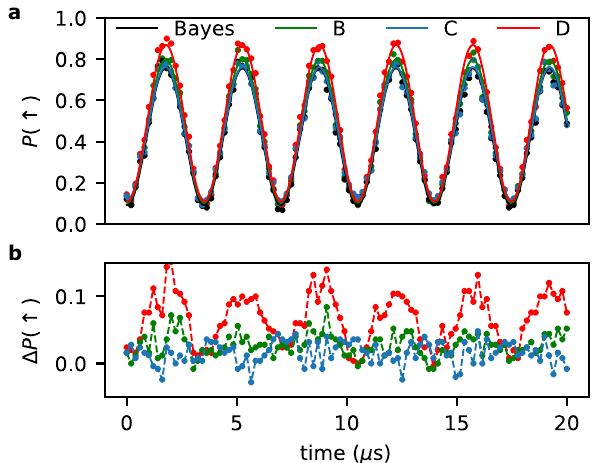
Figure 3. Detection of a Rabi-driven single electron spin analysed by different post-processing methods. ( a ) Spin |↑� -probability P ( |↑� ) as a function of the driving time t . The same measurement traces are classified by the Bayesian inference filter, and the neural networks B , C and D . Solid lines are fits to Eq. (3). ( b ) P ( |↑� ) from panel ( a ) classified by the neural networks B , C and D each subtracted by P ( |↑� ) classified by the Bayesian inference filter (colors equal to panel a